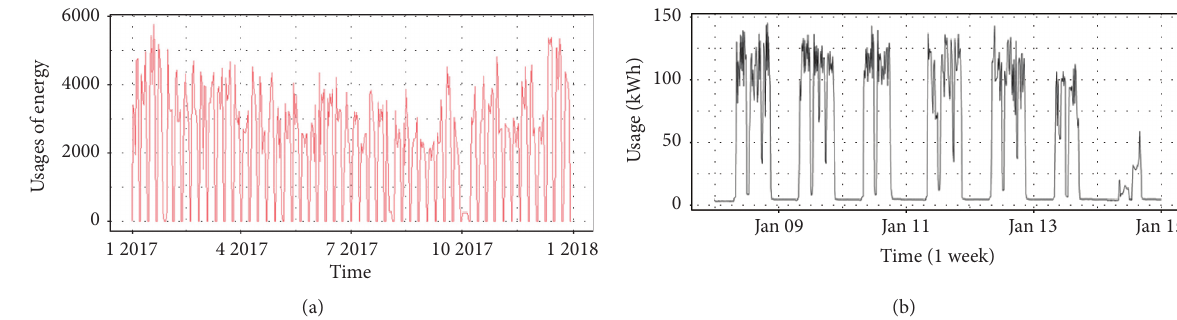
Figure 4: (a) Industry energy consumption measurement for the whole period. (b) Industry energy consumption for the first week.